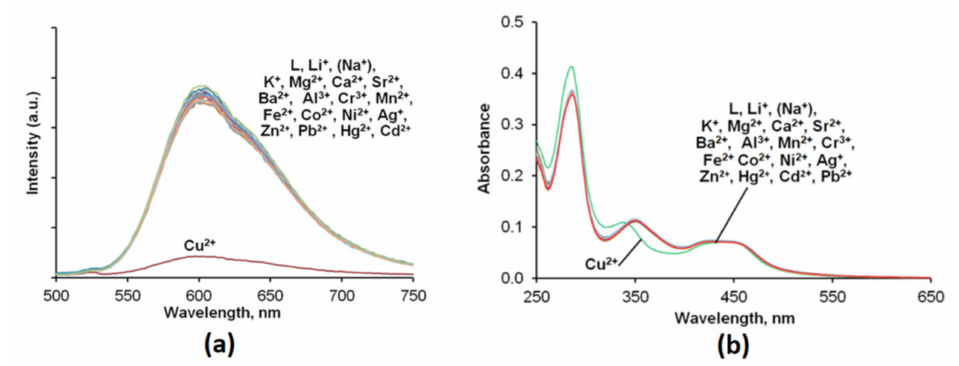
Figure 4. Fluorescence ( a ) and absorption spectra ( b ) of the Ru(N 2 P 2 phen) solution before and after addition of 15 equivalents of metal perchlorate salts. [ Ru(N 2 P 2 phen) ] tot = 5.4 µ M, pH = 7.4, [HEPES] = 0.03 M, and [M n+ ] tot = 81.0 µ M for each metal ion. λ ex = 450 nm.